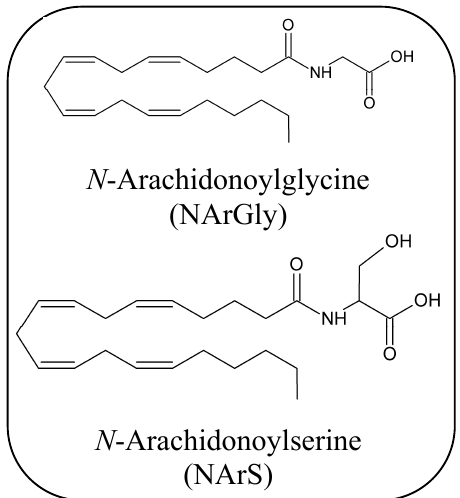
Figure 2. Chemical structures of some endocannabinoid-like molecules.